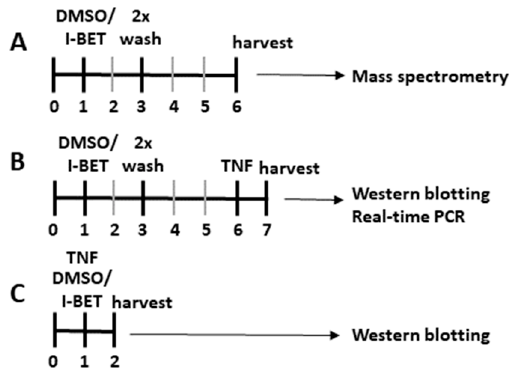
Figure 1. Treatment schemes. ( A ) FLSs were treated with I-BET151 or DMSO (control) on day 1 and ( A ) harvested on day 6 for mass spectrometry, or ( B ) treated with TNF for another 24 h and harvested for Western blotting or RNA isolation. ( C ) FLSs were treated with I-BET151 or DMSO (control) in absence and presence of TNF for 24 h and harvested for Western blotting. In all experiments, control and I-BET151-treated FLSs were derived from the same donors.